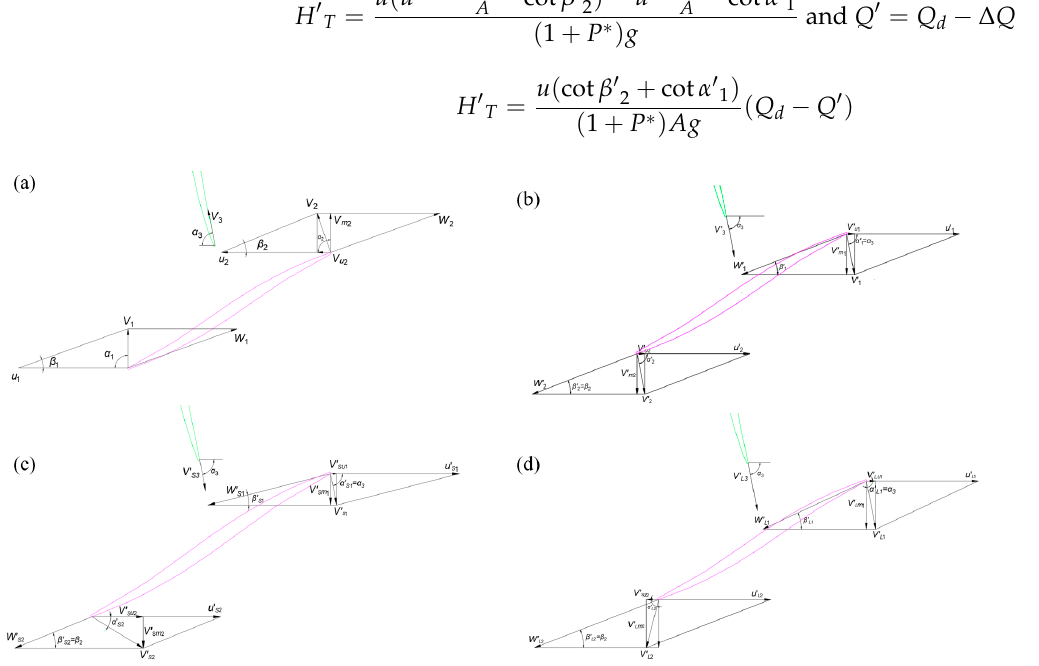
Figure 6. Velocity triangles for the symmetric airfoil blade at inlet and outlet for: ( a ) forward operation at Q = Q d ; ( b ) reverse operation at Q ′ = Q d ; ( c ) reverse operation at Q ′ < Q d ; ( d ) reverse operation at Q ′ > Q d .